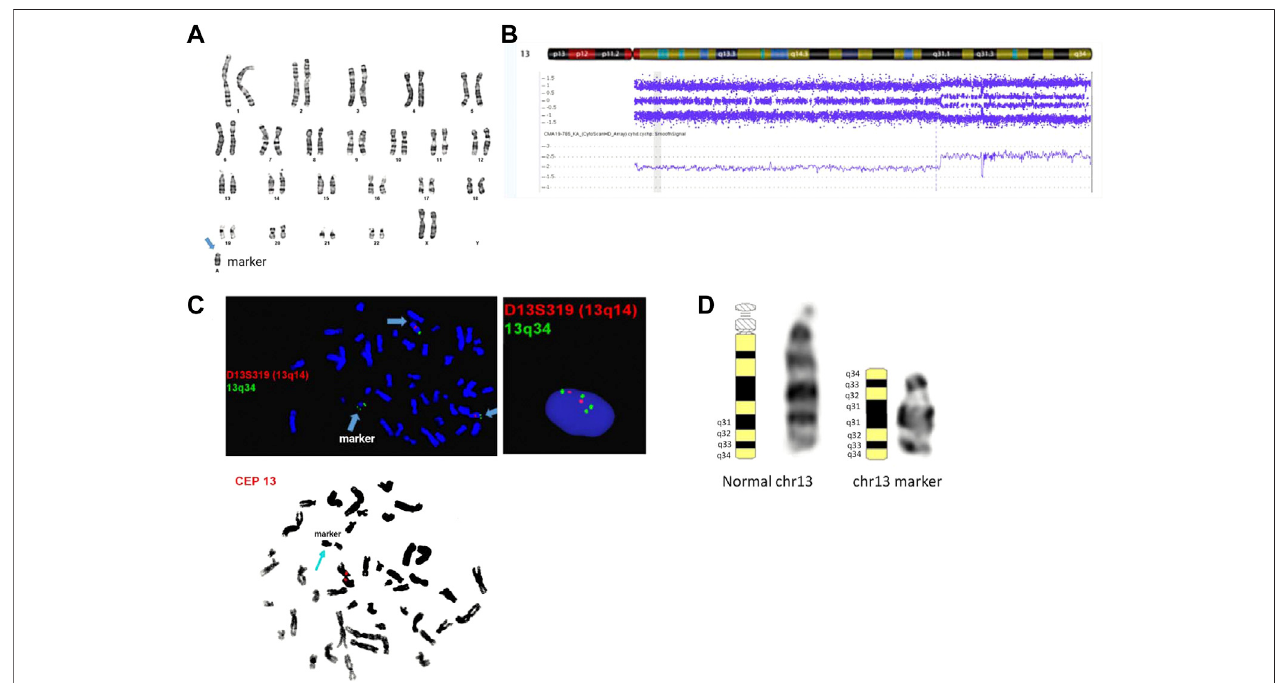
FIGURE 2 | Cytogenetic and genomic characterization of the sSMC. Panel (A) : female karyotype with a small supernumerary marker chromosome identi fi ed by G-banding from amniotic fl uid; banding resolution: 400-band-level; panel (B) : SNP-based microarray results showing 31.34 Mb gain in the distal end of chromosome 13q: arr [GRCh37] 13q31.1q34 (83,666,539_115,010,330)x2~4; probe targets: 2,696,550; human genome build (hg19); panel (C) : metaphase and interphase FISH results using probes mapping to 13q14 (D13S319), 13q34 (LAMP1), and chr 13 centromere. The fi nal karyotype is: 47,XX,+mar[28]/46,XX[2]. nuc ish (D13S319x2,LAMP1x4)[122/300]. ish der (13) (D13S319,LAMP1++) (CEP13-); panel (D) : chromosome 13 ideograms showing representative normal and marker chromosome 13 in the patient. The long form description of the marker chromosome cell line as per ISCN 2020 is as follows: 47,XX,+dup (13) (qter- > q31.1::q31.1- > q33- > neo- > q33- > qter).